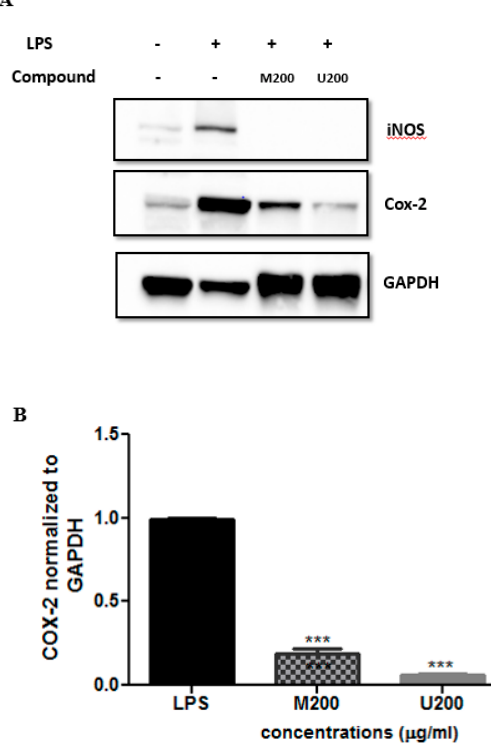
Figure 3. Protein expression levels of COX-2 and iNOS in LPS-treated RAW 264.7 cells assessed by Western blot. ( A ) Cells were co-treated with LPS (10 ng/ml) and each tested extracts (200 µ g/mL; M: maceration; U: ultrasound) for 24 h. Total protein extracts were made and subjected to western blot analysis using the indicated antibodies. Representative western blots are shown. Expression levels of COX-2 proteins ( B ) were quantified by densitometry and normalized to GAPDH, and expressed as fold change over LPS. Results are shown as mean ± SEM of three independent experiments. Sta- tistics were performed using one-way ANOVA, followed by Bonferroni's Multiple Comparison Test. (*** p < 0.001)